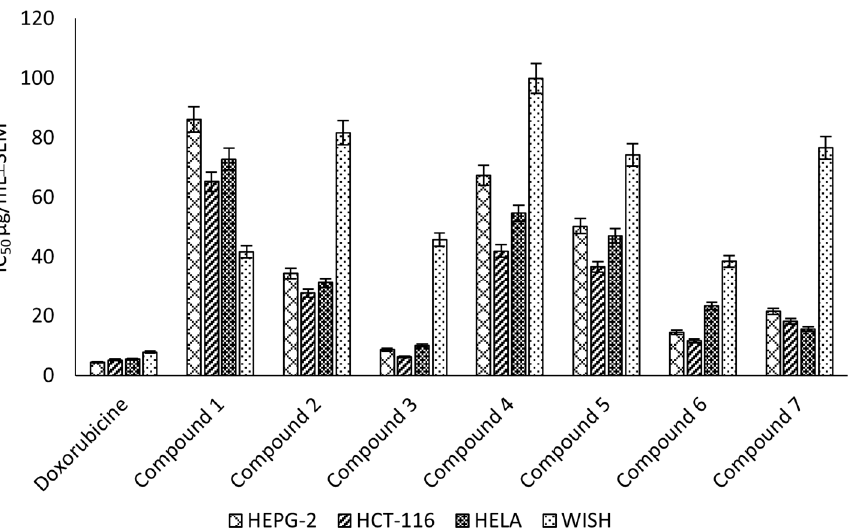
Figure 5. Cytotoxic effect (IC 50 ± SEM) of C. rumphii isolated compounds against the HEPG-2, HCT-116 and HELA cell lines.